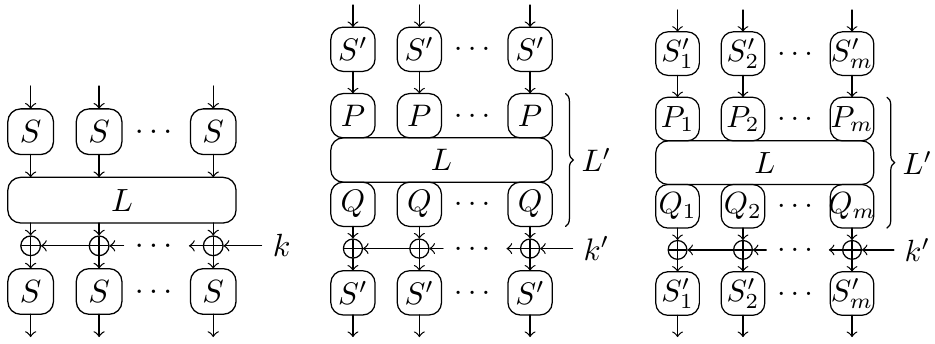
Figure 1: A keyed round function of an SPN with one additional S-box layer (left), an alternative representation of the round with S ′ = P − 1 ◦ S ◦ Q − 1 (middle), and an alternative representation of the round with S ′